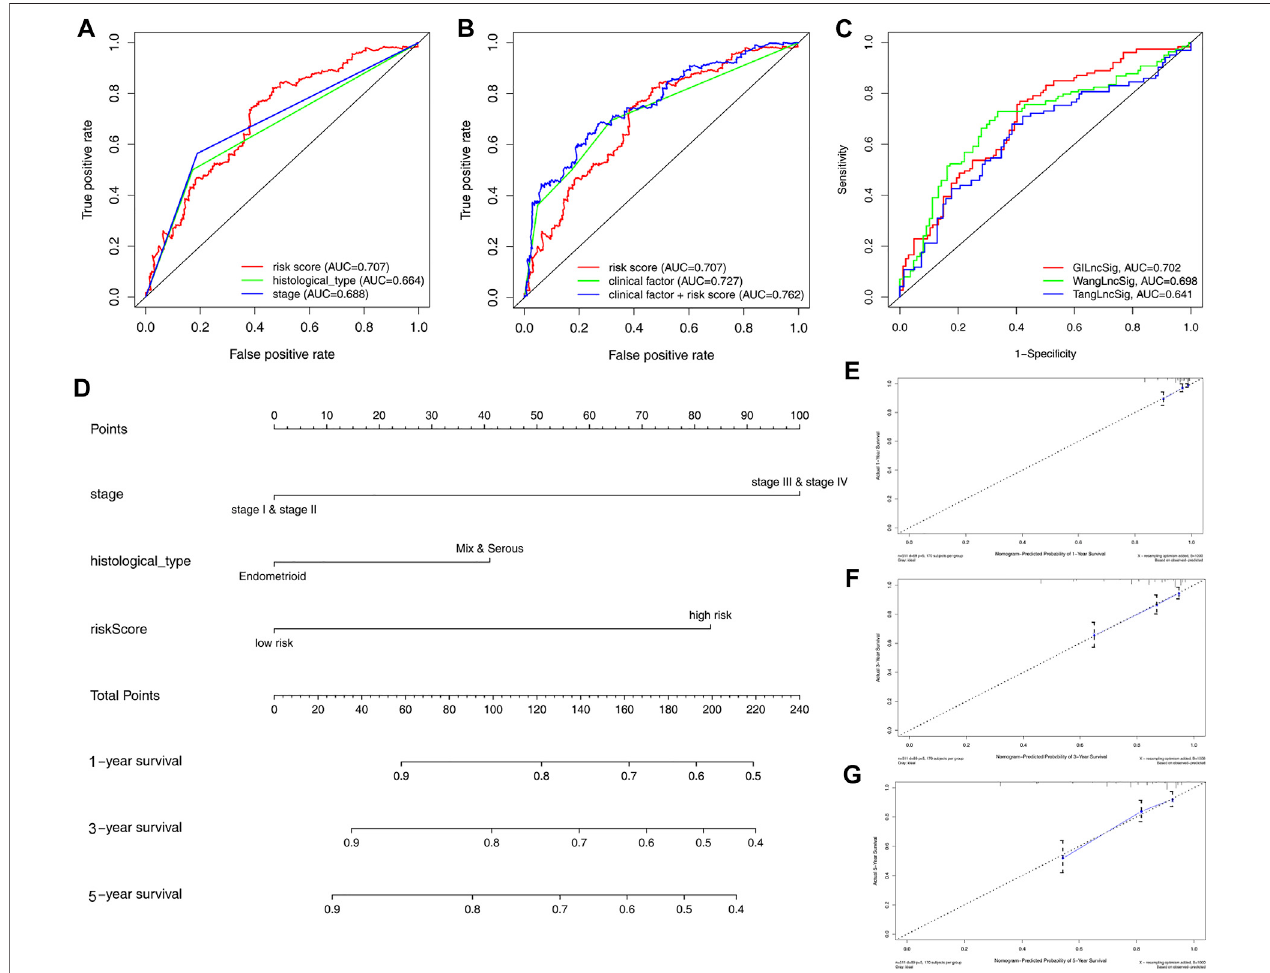
FIGURE 4 | Construction of nomogram for predicting survival of patients with EC. (A) Time-dependent ROC analysis to evaluate prognostic value of the risk score andclinicalfactors(histologicaltypeandstage). (B) Time-dependentROCanalysisbasedonriskscoreandmergedclinicalfactors. (C) Time-dependentROCanalysisof OS for the GILncSig, WangLncSig, and TangLncSig. (D) The baseline nomogram from three clinicopathological parameters (stage, histological type, and risk score). (E – G) Calibration plots of 1-, 3-, and 5-year OS for the patient with predicting.